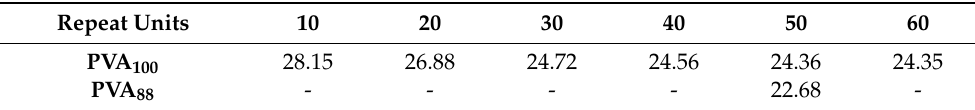
Figure 4. ( a ) The relationship between the number of repeat units and solubility parameters of PVA (298.15 K); ( b ) single-chain model of PVA with two alcoholysis degrees; ( c ) amorphous structure of PVA with two alcoholysis degrees; ( d ) energy and temperature distribution of PVA with two alcoholysis degrees. Table 6. Solubility parameters of PVA with different alcoholysis degrees simulated by molecular dynamics (at 298.15 K). Repeat Units